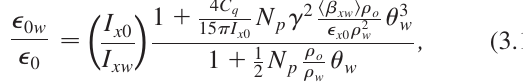
FIG. 8. All 3rd-order resonance terms in f by the 10 families of sextupoles as they accumulated in the PEP-X